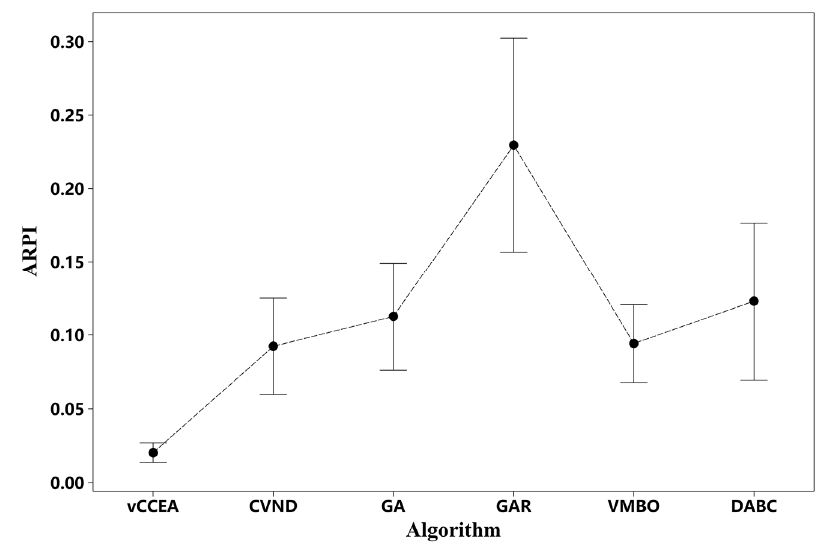
Figure 9. Confidence interval graph for these six algorithms. Table 7. Comparison results of vCCEA and other algorithms on